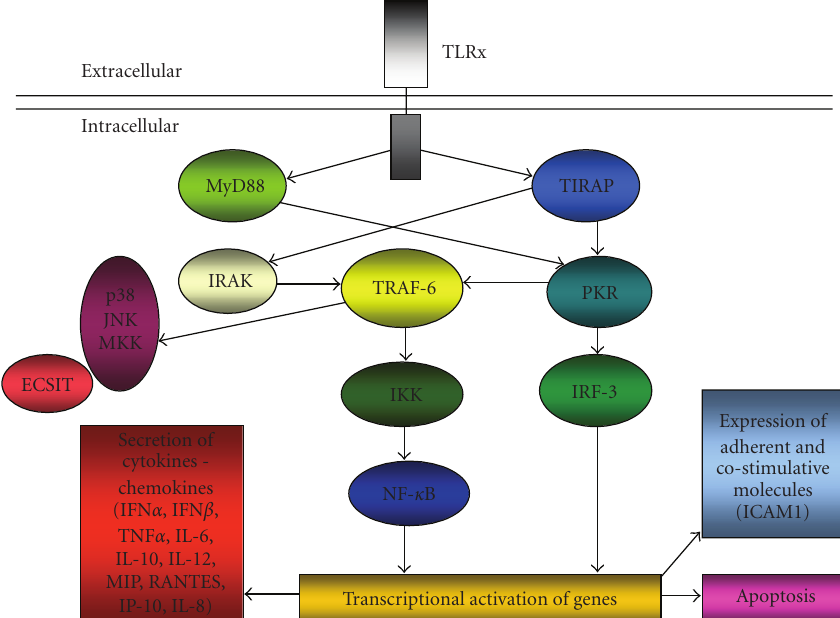
Figure 2: Toll-like receptor (TLR) signalling is mediated by at least two distinct pathways. After recognition of a pathogen-specific molecular pattern, TLRs are capable of di ff erentially activating distinct downstream signalling events via di ff erent cofactors and adaptor proteins mediating diverse immune responses [1]. The MyD88-dependent TLR signalling pathway is activated via the conserved, cytoplasmic TIR domain, which provides a sca ff old for recruitment of the adaptor molecule MyD88 and serine/threonine kinases of the IL-1R- associated kinase (IRAK) family. Following IRAK autophosphorylation, the TRAF6 adaptor protein interacts and induces translocation of the transcription factor NF- κ B to the nucleus, resulting in transcriptional activation of genes encoding cytokines and chemokines (TNF- α , NO, COX-2, SOCS (for “suppressor of cytokine signalling”), IP-10, IFN-b and IL-1, 6, 8, 10, 12). In addition, expression of proteins involved in apoptosis and production of adherent and costimulative molecules such as ICAM1, occur. Moreover, TLRs bridge the signalling pathway via ECSIT (for “evolutionarily conserved signalling intermediate in Toll pathways”) to TRAF6 for p42/p44 mitogen-activated protein kinase (MAPK) kinase (MKK), p38, and JNK in response to specific bacterial products [2]. The MyD88-independent TLR signalling pathway is activated via TIRAP and results in activation of the dsRNA-binding protein kinase PKR. This protein has been proposed to be a central downstream component of both the TIRAP- and MyD88-dependent signalling pathways and could mediate potential crosstalk between them. The MyD88-independent pathway appears to utilise both IFN-regulatory factor 3 (IRF3) and NF- κ B, and results in the expression of IFN-g-inducible genes including